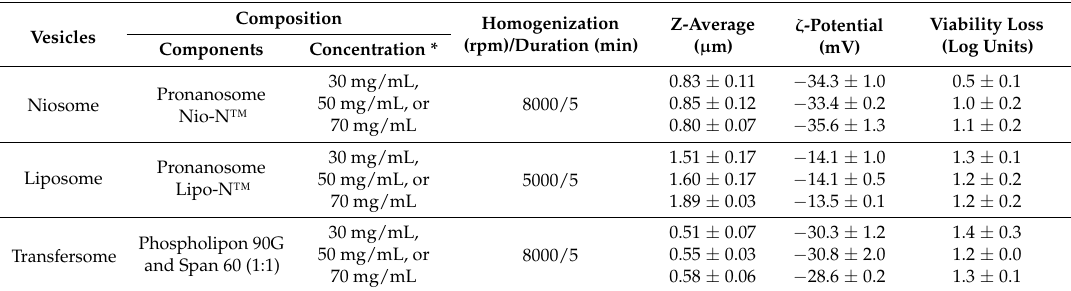
Table 1. Composition, characteristics (homogenization and duration, size, zeta potential) and viability (measured as log reduction in phage titer after treatment comparing with the initial titer) of vesicles containing phage